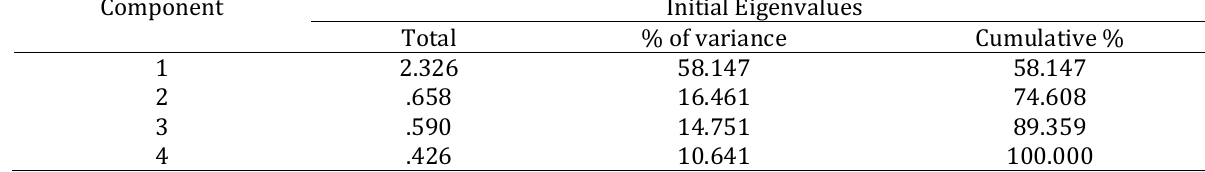
Table 4: Results of Eigen analysis of covariance matrix of the machine learning variables